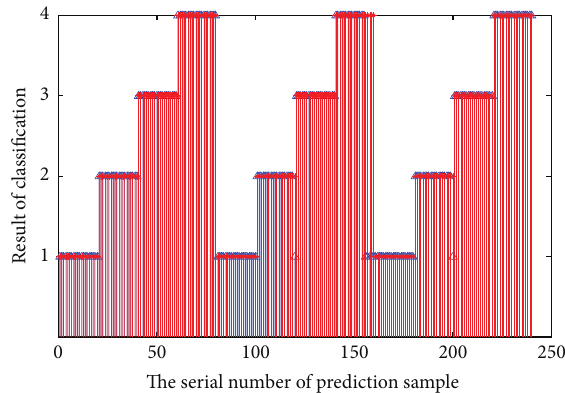
Figure 18: The classification result of the fourth cross-validation